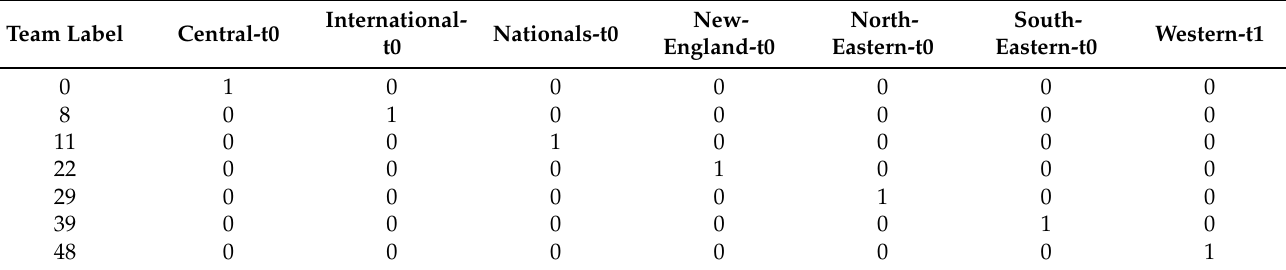
Figure 4. Distribution of number of commands entered per team. In the preprocessing stage, we also removed the timestamps of the bash commands. Further data pre-processing included label encoding and text vectorizing. To ob- tain binary representation for each team, one-hot encoding was applied; for example, team nationals-t0 was assigned vector 11 and team international-t1 was assigned vector 9. Tables 5 and 6 show the key steps of these transformations for the selected teams. Table 5. One-hot representation of team names.